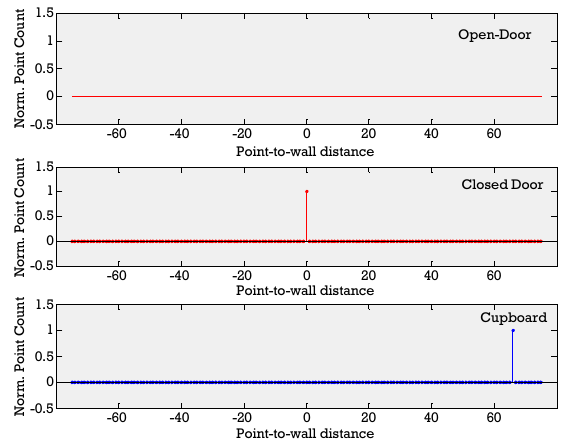
Figure 3. Theoretical normalized density of points. For open- doors, there are not any points in front or behind the wall. For closed-doors and cupboards, all points are on the plane, near to the wall for doors and away from it for